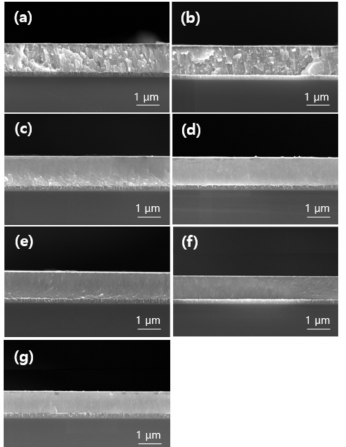
Figure 1. Cross-sectional SEM images of the Mo–Cu–Cr–(N) coatings prepared at N 2 gas flow rates of ( a – g ) 0, 3, 6, 9, 12, 15, and 18 sccm,